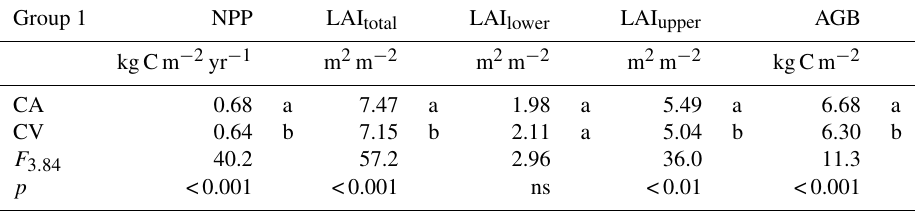
Table 3. Summary of average NPP, LAI and AGB for the Amazon–Cerrado transition zone over the transect domains, considering all simulations with CA and CV, regardless of fire presence or P limitation. One-way ANOVA results are also shown, including F statistics and p values. Values within each column followed by a different letter differ significantly ( p <0.05) according to the Tukey–Kramer test ( n = 1860: 31 pixels × 10 years × n simulation /2).